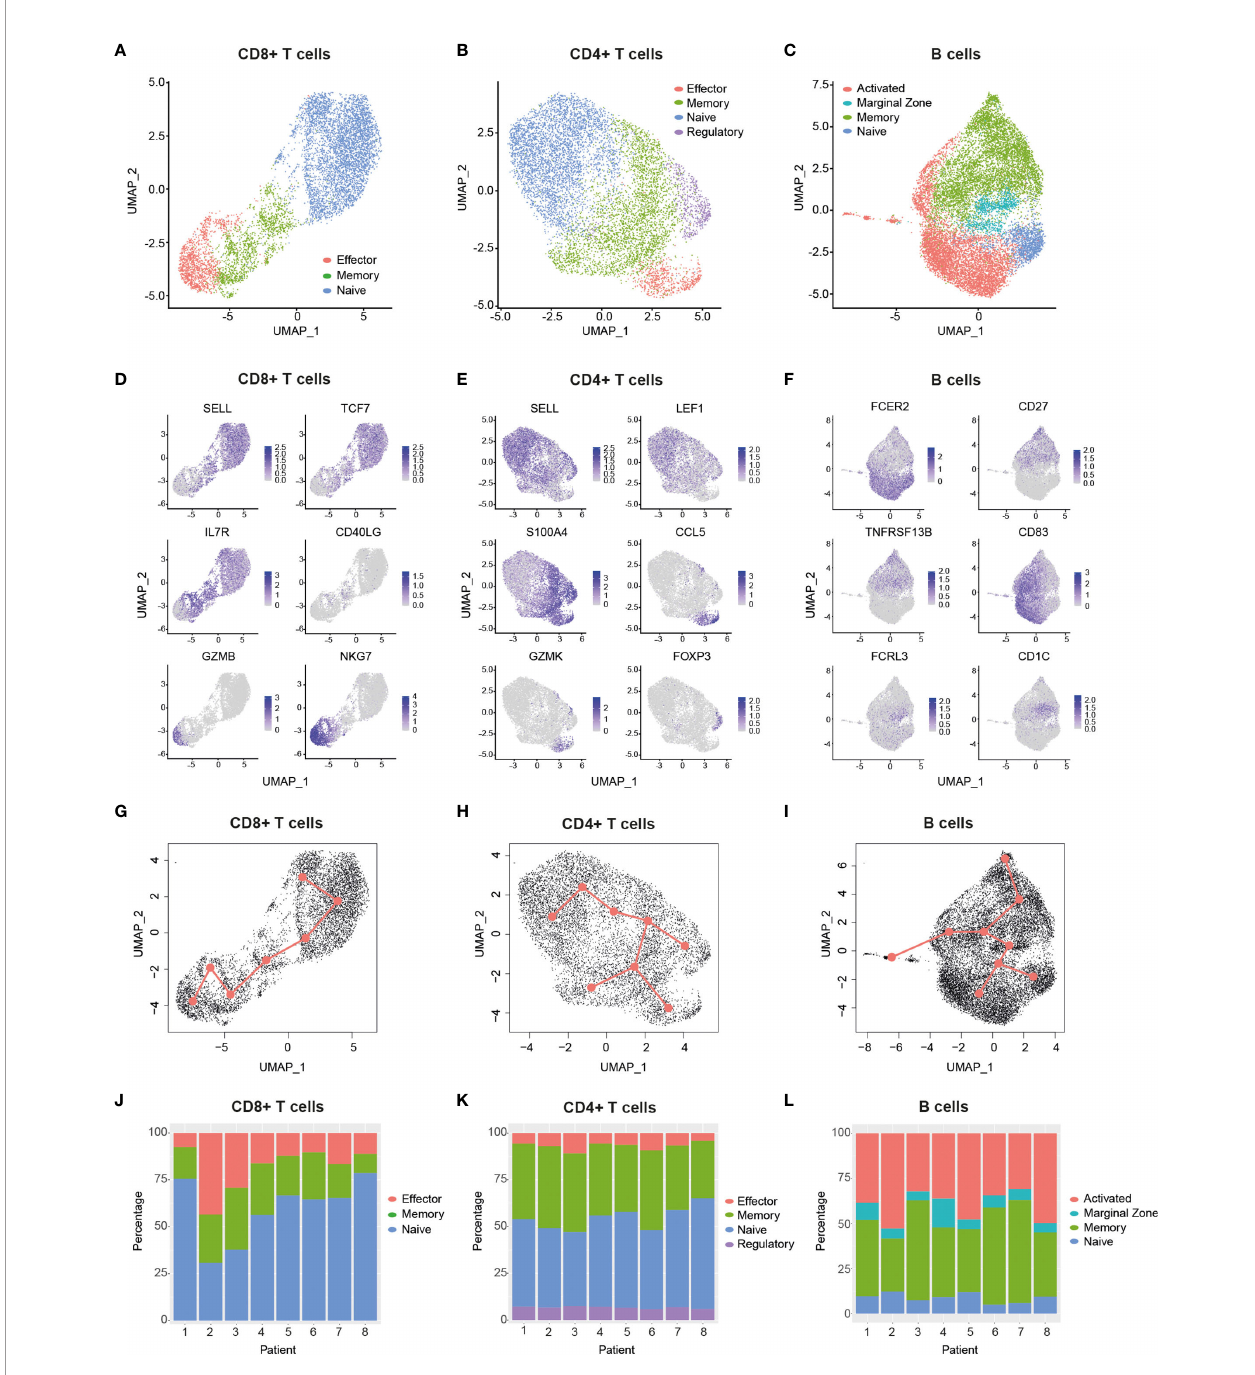
FIGURE 2 | Single-cell transcriptomic analysis delineates major T and B cell subsets. (A – C) , Uniform manifold approximation and projection (UMAP) plots of major cellular subsets identi fi ed within the CD8+ T cell (A) , CD4+ T cell (B) and B cell (C) populations. Cells from all patients are displayed in each plot.9 (D – F) , UMAP plots showing the expression levels of selected genes used to delineate cellular subsets within the CD8+ T cell (D) CD4+ T cell (E) and B cell (F) populations. Cells from all patients are displayed in each plot. g-i, Graphs display pseudotime and trajectory inference analysis applied to CD8+T cell (G) , CD4+ T cell (H) and B cell (I) clusters. (J – L) , Bar graphs show the proportions of identi fi ed cellular subsets within the CD8+ T cell (J) , CD4+ T cell (K) and B cell (L) populations in each patient. CCL5, C-C Motif Chemokine Ligand 5; CD27, TNFRSF7; CD40LG, CD40 ligand; FCER2, Fc Fragment of IgE Receptor II (also: CD23a); FCRL3, Fc Receptor Like 3; FOXP3, Forkhead Box Protein P3; GZMB, Granzyme B; GZMK, Granzyme K; IL7R, Interleukin-7 Receptor; LEF1, Lymphoid Enhancer Binding Factor 1; NKG7 , Natural Killer Cell Granule Protein 7; S100A4, S100 Calcium Binding Protein A4; SELL, Selectin L; TCF7, Transcription Factor 7; TNFRSF13B, TNF Receptor Superfamily Member